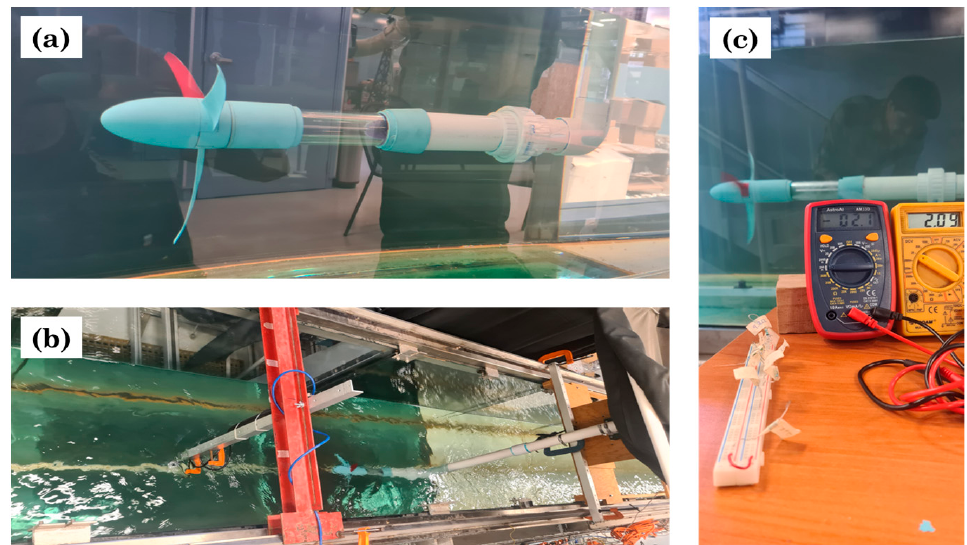
Figure 9. Flow tank tests set ‐ up: ( a ) Leak tests, ( b ) Upstream positioning of measurement device, ( c ) Multimeters and protoboard connected to the gear motor.